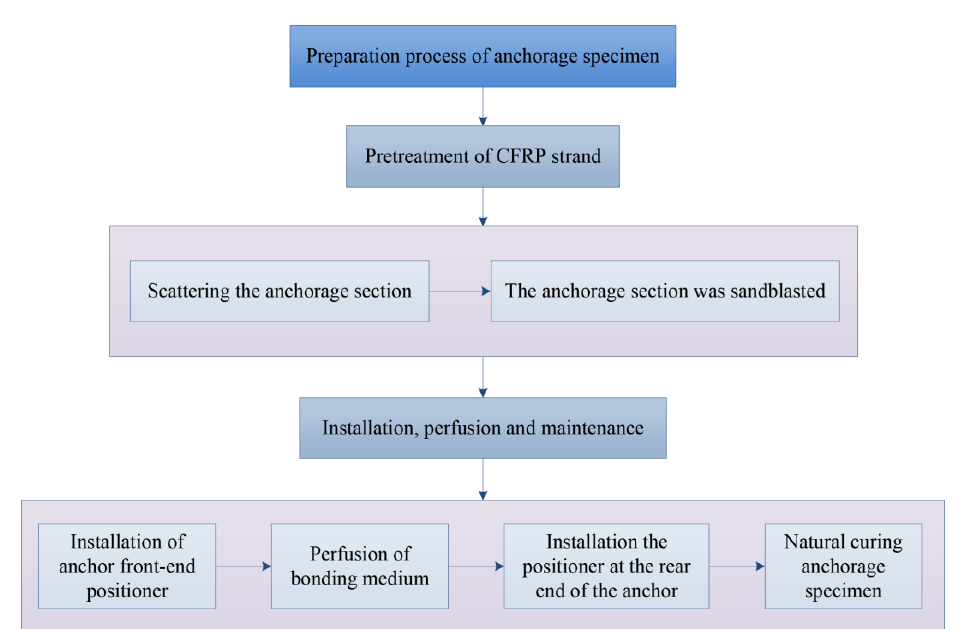
Figure 7. Flow diagram of CFRP strand anchorage process.